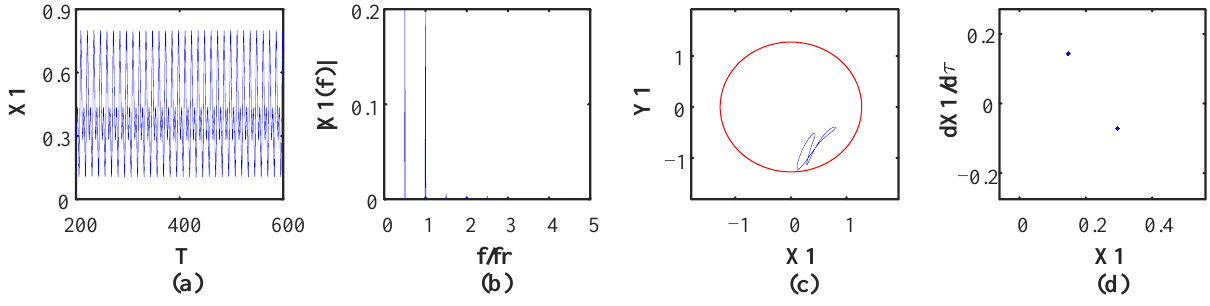
Figure 6. Numerical integration results at ω = 546 rad/s: ( a ) Time domain waveform; ( b ) Frequency spectrum; ( c ) Shaft orbit; ( d ) Poincaré map.